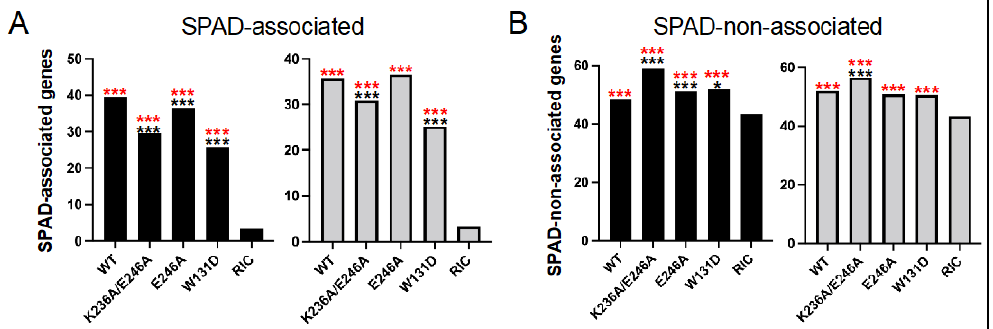
Figure 7. SPAD-associated gene integration defect of class II IN mutant viruses. ( A ) Frequencies of SPAD-associated gene integration for the noted viruses. The left graph is data from replicate 1. ( B ) Same as in panel ( A ), except for SPAD-non-associated genes. Asterisks show differences versus matched RIC (red) and WT HIV-Luc (black) controls. *, p < 0.01; ***, p < 0.0001—see Table S5 for detailed statistical analyses.